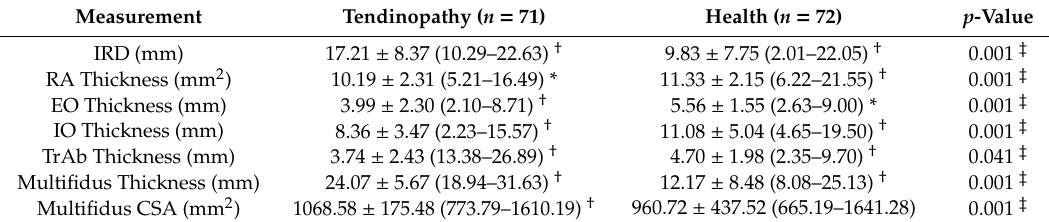
Table 2. Ultrasound imaging measurements between groups.